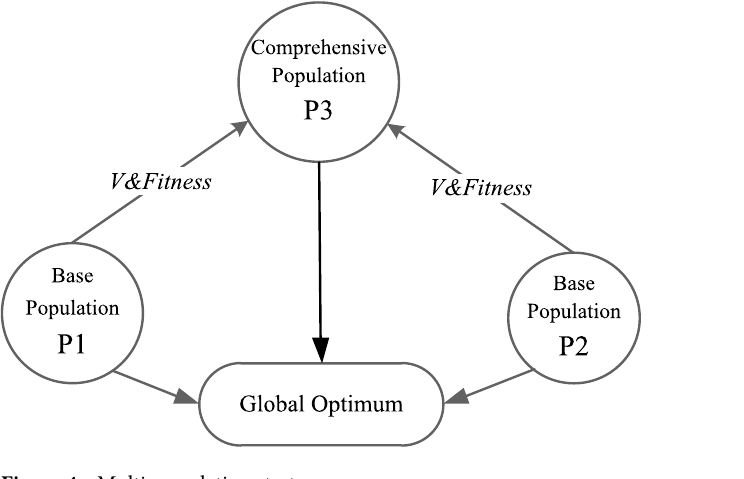
Figure 4. Multi-population